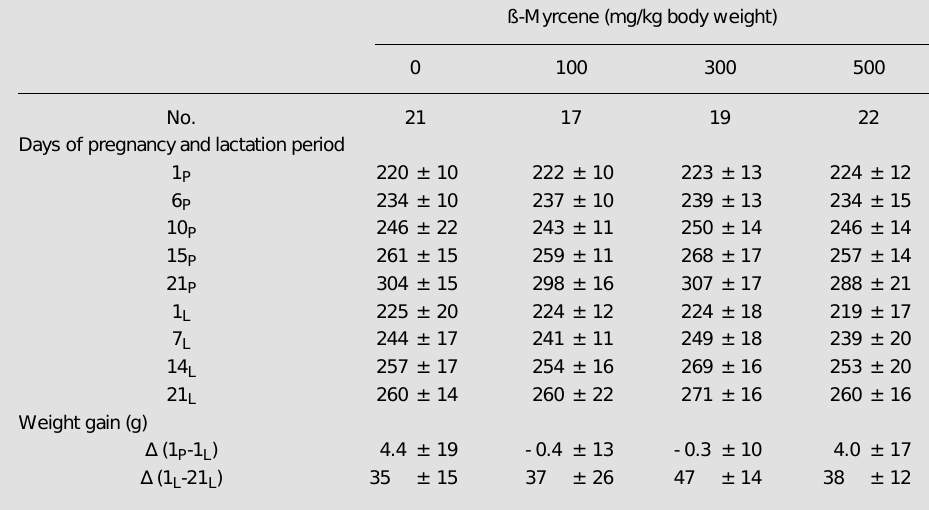
Table 6 - Weight development of female rats treated orally with ß-myrcene (0, 100, 300 and 500 mg/kg body weight) during pregnancy and lactation. Values are reported as means ± SD. Data were analyzed by ANOVA and the Student t -test and no significant differences were detected. Dams submitted to cesarean section on pregnancy day 21 were not included. Days of pregnancy and days of lactation are indicated by subscripts P and L,